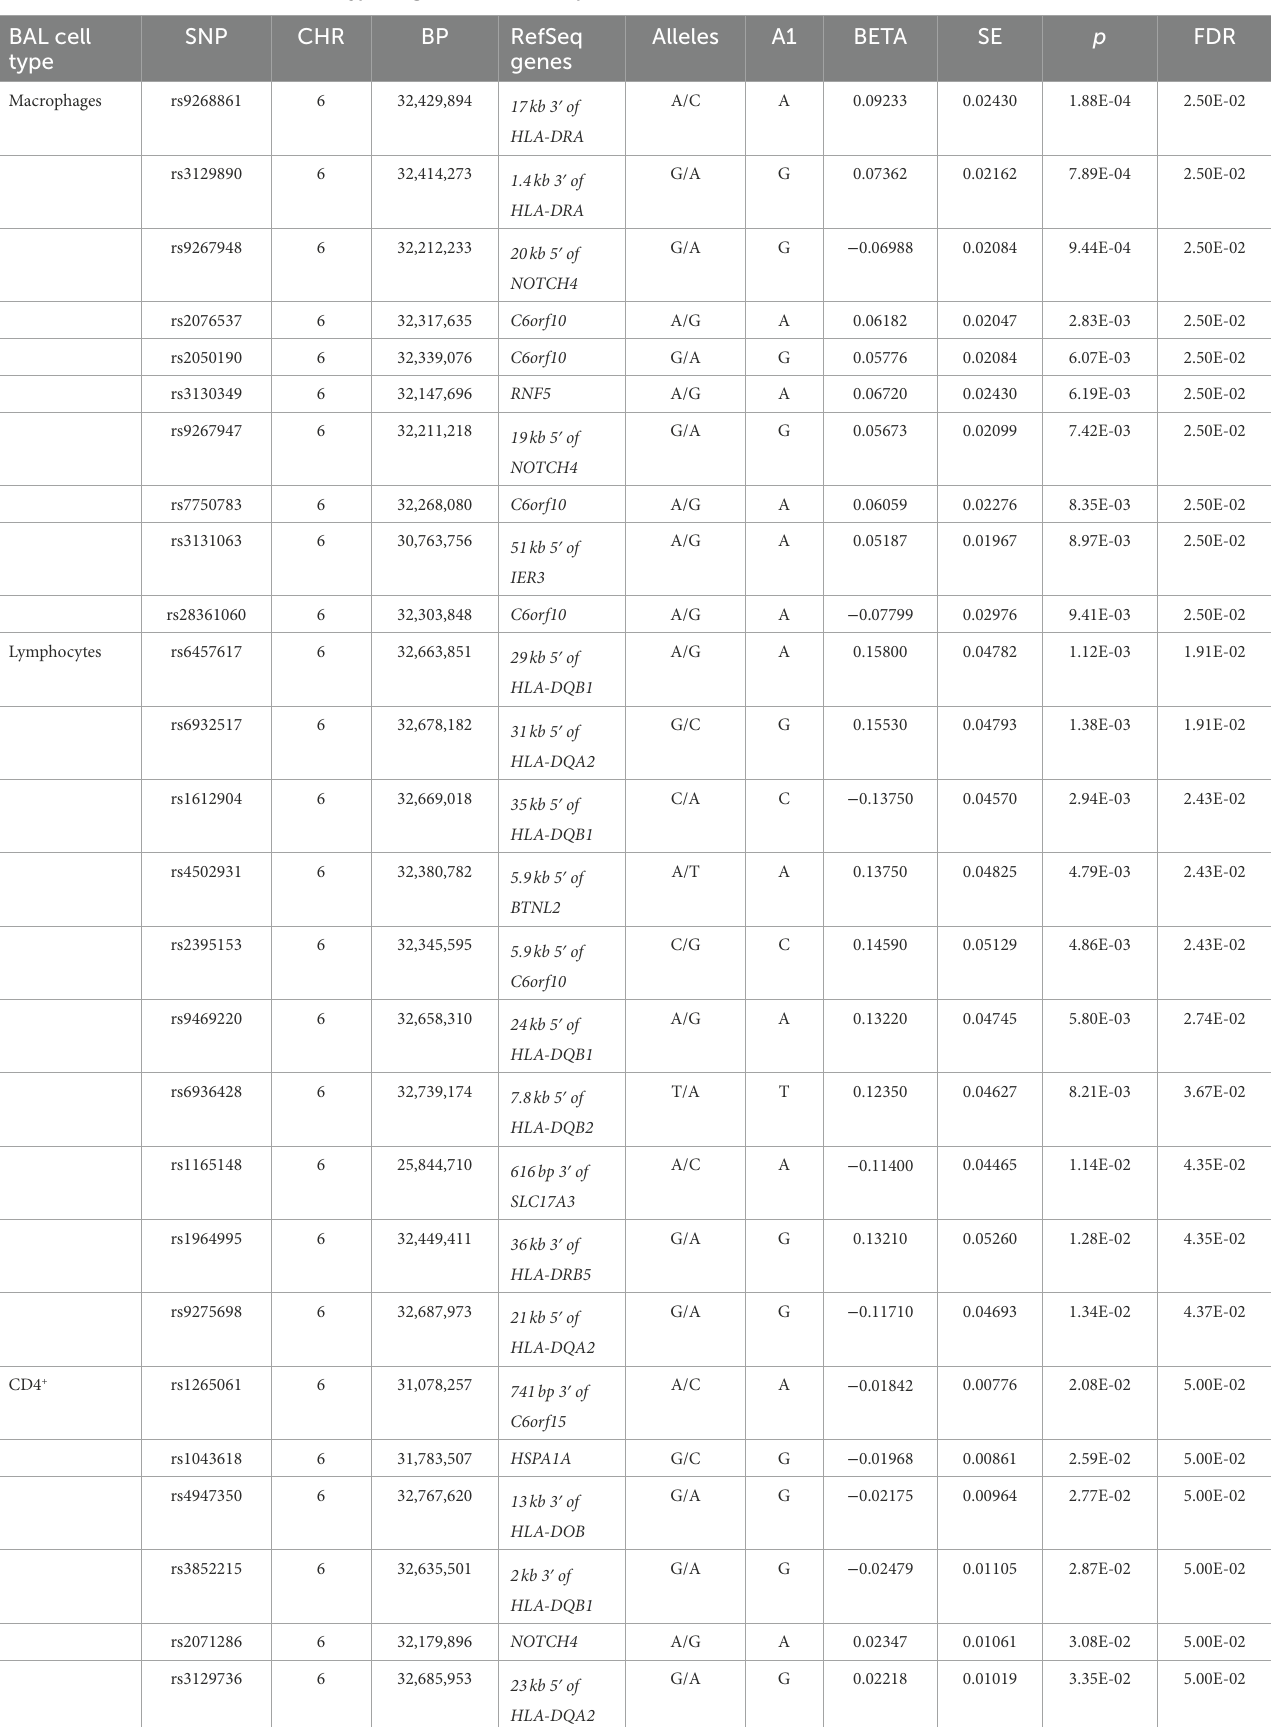
TABLE 2 Association results of LS BAL cell types (log10-tranformed of quantitative levels). BAL cell